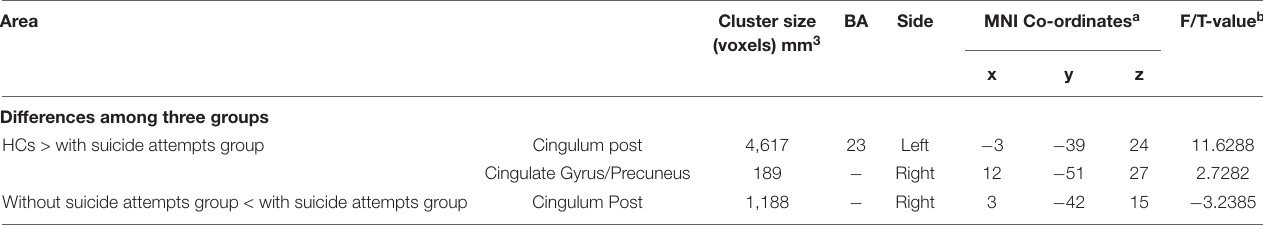
TABLE 2 | Regions showing significant differences in regional homogeneity (ReHo) among major depressive disorder (MDD) with/without suicide attempts (SA) and healthy controls.